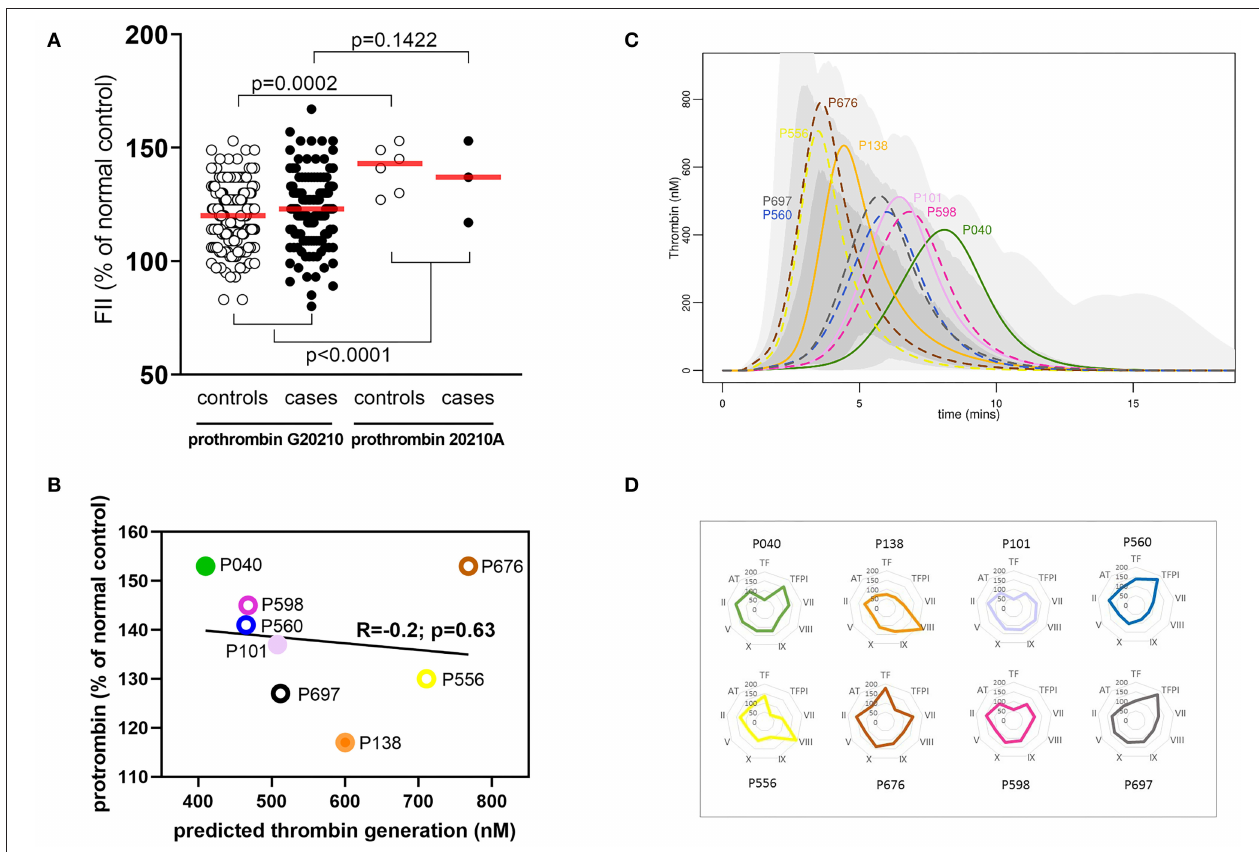
FIGURE 4 | A single coagulation factor does not control the hemostatic profile. (A) Effect of Prothrombin variant G20210GA on plasma FII levels in pMI cases and healthy donors. Data are expressed as a percent of the reference standard, and the red bar indicates the mean for each group. (B) Correlation between plasma FII levels (x-axis) and predicted thrombin generation (y-axis) in plasma from individuals with the prothrombin G20210GA variant. FII levels are expressed as the percent of the reference standard. Filled symbols represent pMI cases; open symbols represent controls. (C) Predicted thrombin generation for the sub-group of donors with the prothrombin variant G20210A. Solid lines (case) and broken lines (control) outline the predicted rate of generation, peak activity, and depletion of thrombin for each donor. These are displayed against a shaded region that demonstrates the range of thrombin generated by the whole population of MI and control donors combined (pale gray = whole range; mid-gray = 95% quantile; and dark gray = 75% quantile). (D) Relative concentrations of all coagulation proteins (as the % of normal control reference standard) for individuals with the prothrombin variant G20210A. Spider plots depict the levels of each hemostatic protein for each donor. The colors used in the spider plots correspond to those used for the same donors in figures (B,C)